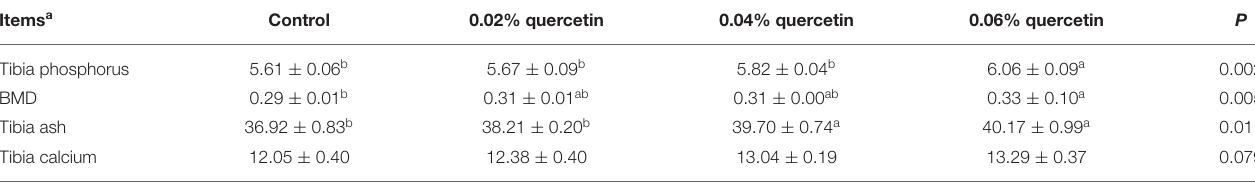
TABLE 4 | Effect of quercetin on content of calcium and phosphorus and bone density in tibia of broilers. Items a